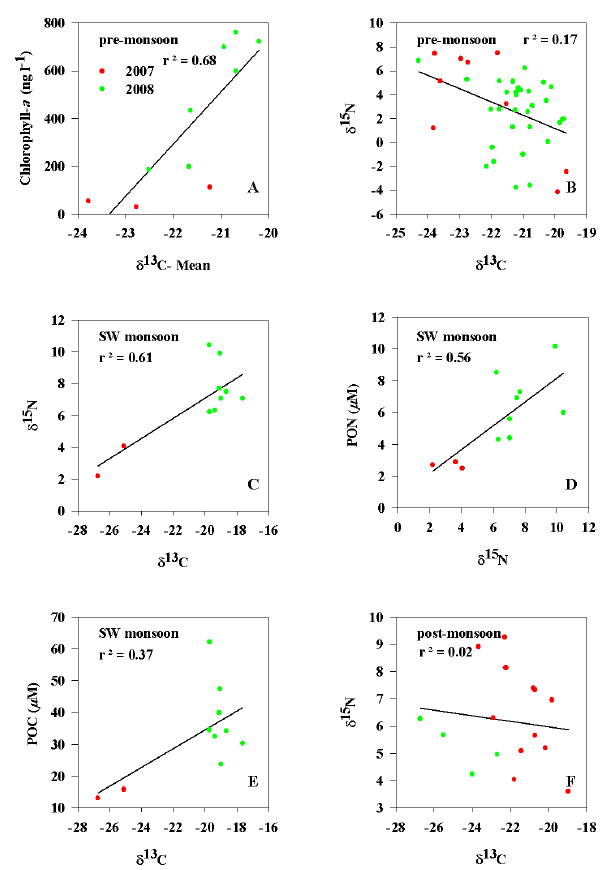
Fig. 5. (A) Correlation between mean δ 13 C and mean total chlorophyll- a during pre-monsoon; (B) Correlation between δ 13 C and δ 15 N during pre-monsoon for all data points; (C) Correlation between δ 13 C and δ 15 N during SW monsoon for all data points; (D) Correlation between δ 15 N and PON during SW monsoon for all data points; (E) Correlation between δ 13 C and POC during SW monsoon for all data points; (F) Correlation between δ 13 C and δ 15 N during post- monsoon for all data